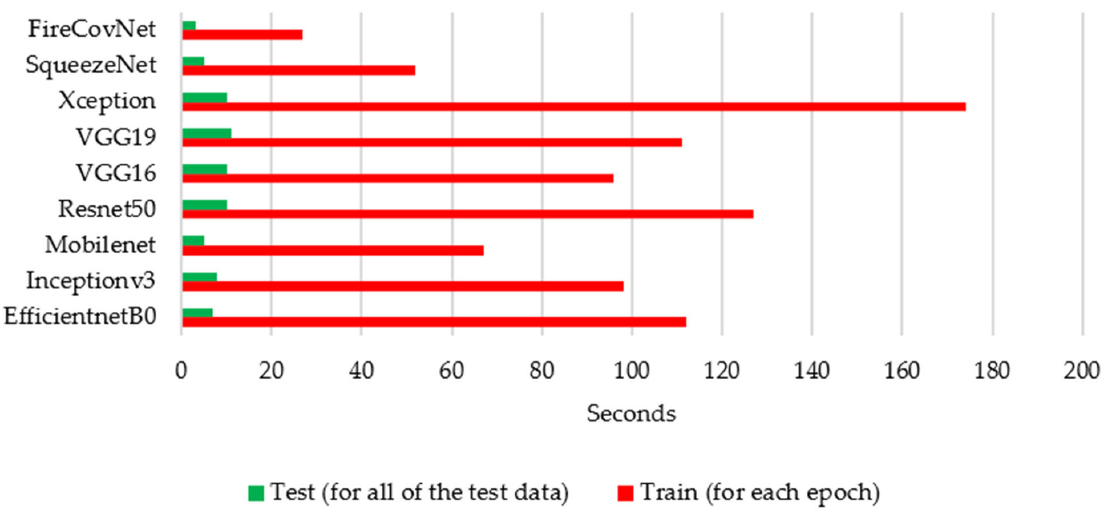
Figure 9. Running time for FirecovNet comparison with eight networks for 5-class classification in 50